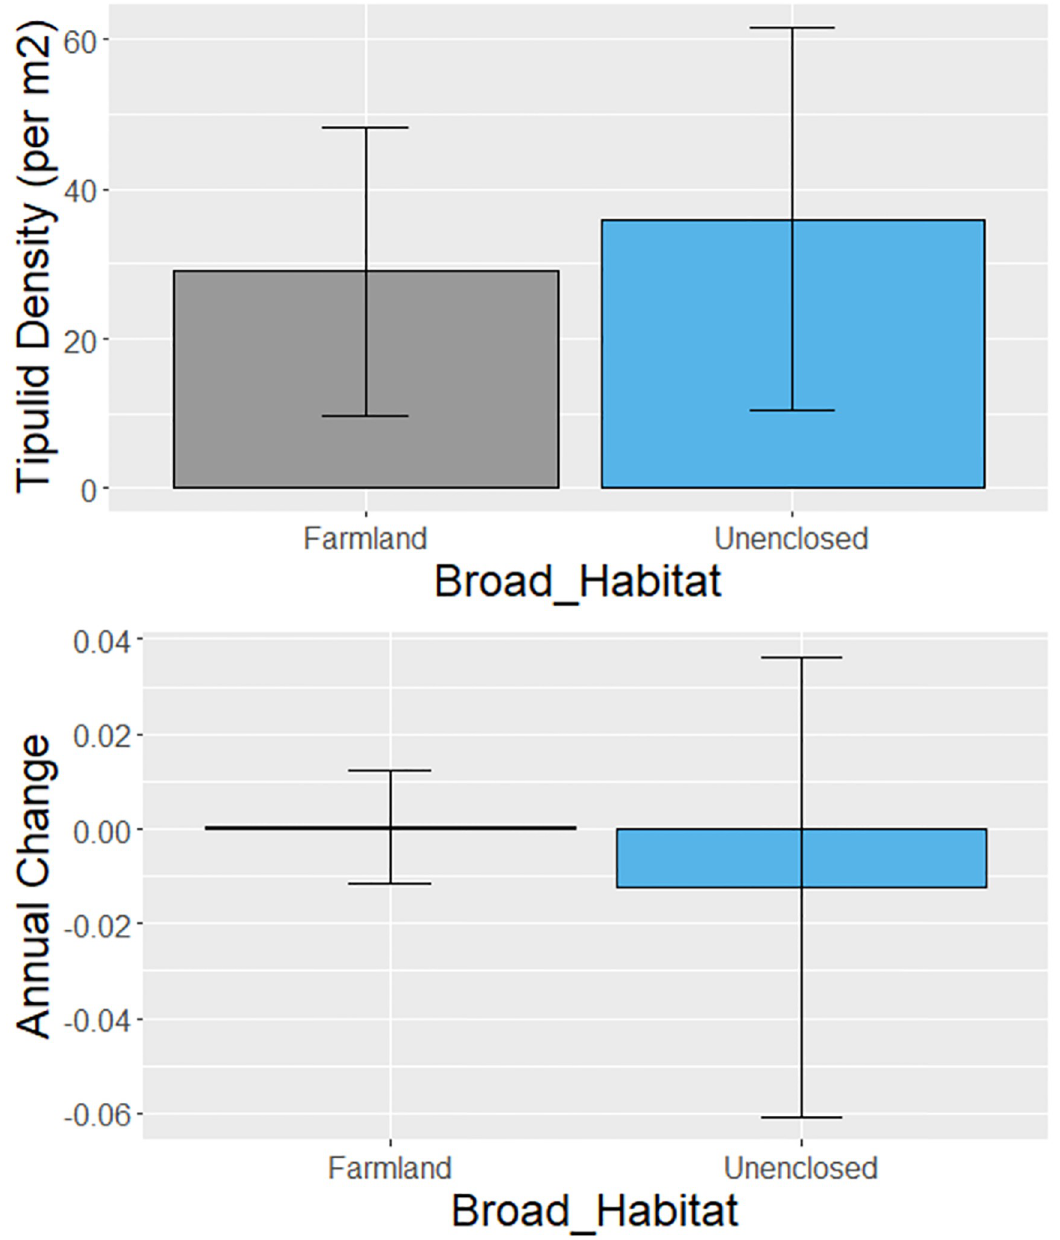
Fig 8. Broad_Habitat specific tipulid density and trend. Average tipulid density per m 2 from unweighted Model 1 (above) and trend estimates (below, not significant) from interaction of unweighted Model 3, for each Broad_Habitat. See Table 7 for